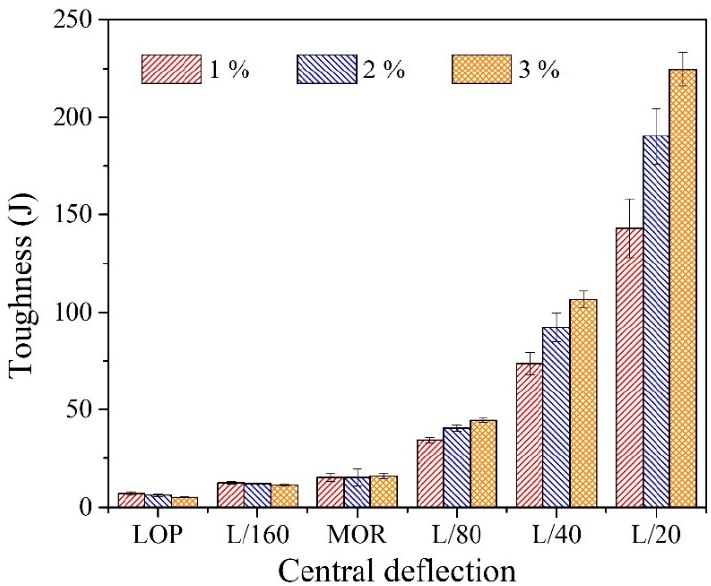
Figure 11. Toughness corresponding to central deflections and fiber proportions.